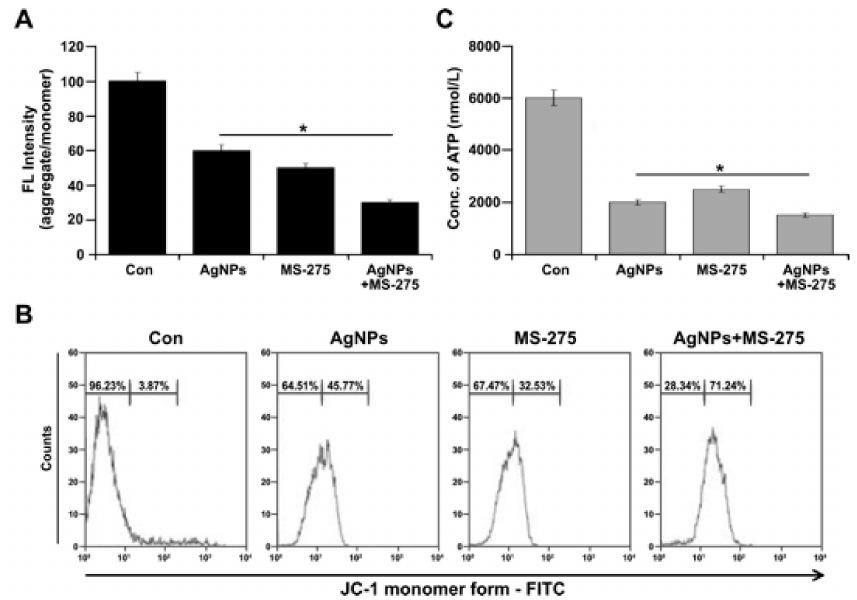
Figure 8. AgNPs and MS-275 cause mitochondrial dysfunction. ( A ) A549 cells were incubated with AgNPs (1 µ M), MS-275 (1 µ M), or a combination of AgNPs (1 µ M) and MS-275 (1 µ M) for 24 h, and the mitochondrial membrane potential was determined using the cationic fluorescent indicator JC-1. The loss of membrane potential was represented as aggregate/monomer ratio. ( B ) JC-1 monomer formation was measured using flow cytometry. ( C ) The concentration of ATP was determined by nanomoles per milliliter. The results represent the means of three separate experiments, and error bars represent the standard error of the mean. Treated groups showed statistically significant differences from the control group with Student’s t -test (* p <